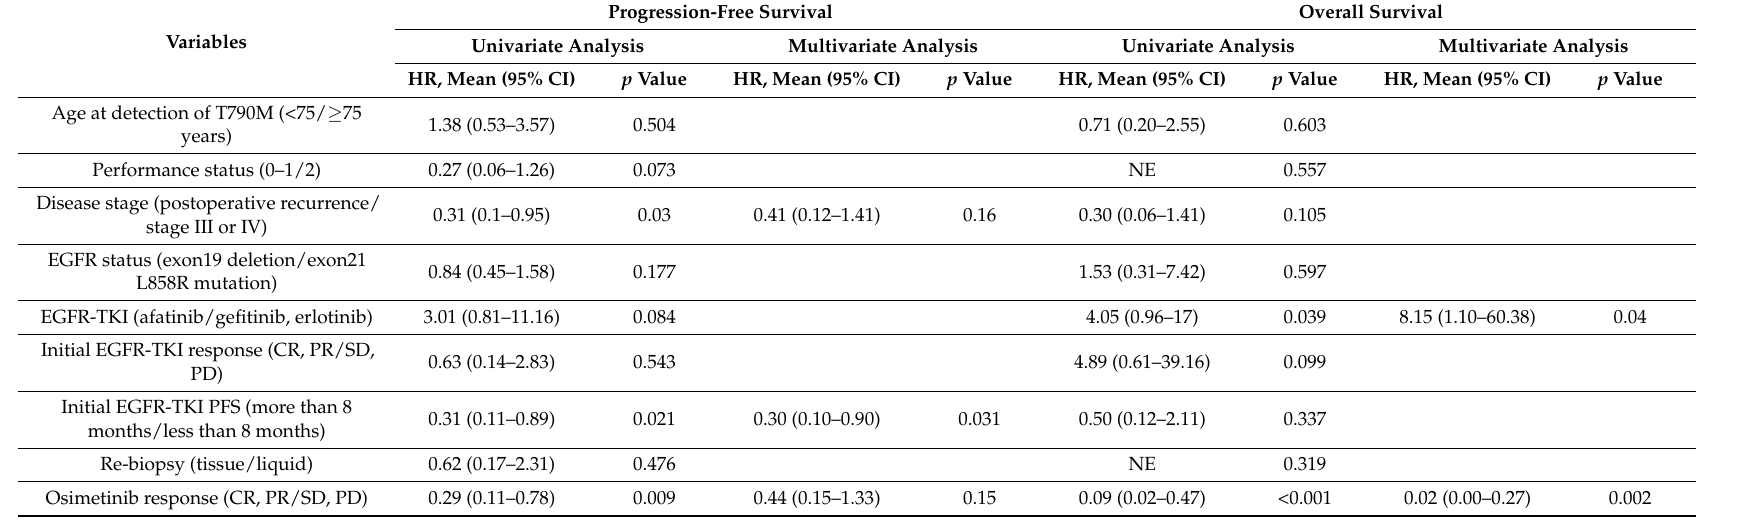
Table 4. Univariate and multivariate analysis of patients’ characteristics and the clinical